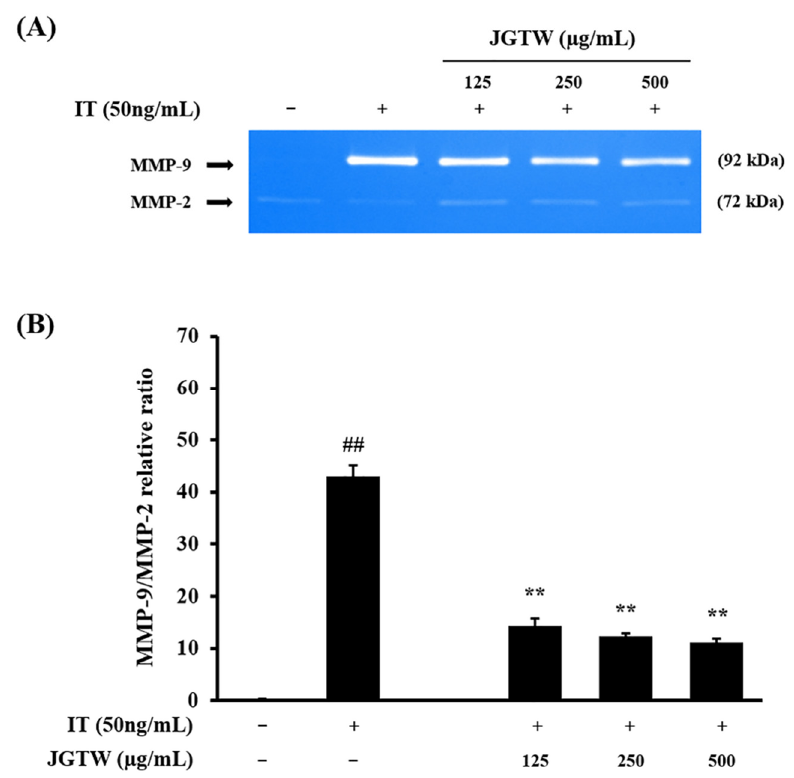
Figure 4. Effect of JGTW on the activity of MMP-9 in BEAS-2B cells. The representative photographs of MMP-9 activity after 48 h IT (50 ng/mL) treatment with or without JGTW pretreatment in gelatin zymography ( A ) and band intensities of MMP-9/MMP-2 ( B ). The values are presented as mean ± SEM. ## p < 0.01 versus vehicle-treated cells; and ** p < 0.01 versus IT-treated cells.